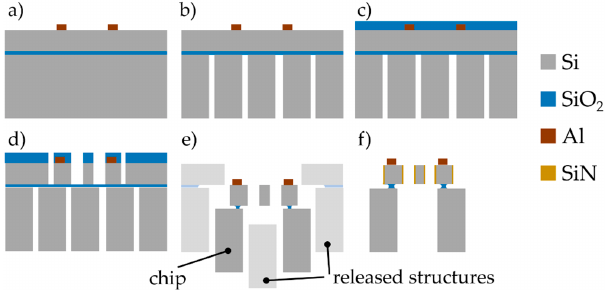
Figure 7. Fabrication process ( a ) etching of bond pads, ( b ) deep-etching of handle layer, c ) PECVD of 400 nm SiO 2 , ( d ) deep-etching of device layer, ( e ) HF-vapor etching, ( f ) deposition of 400 nm SiN, (drawings not to